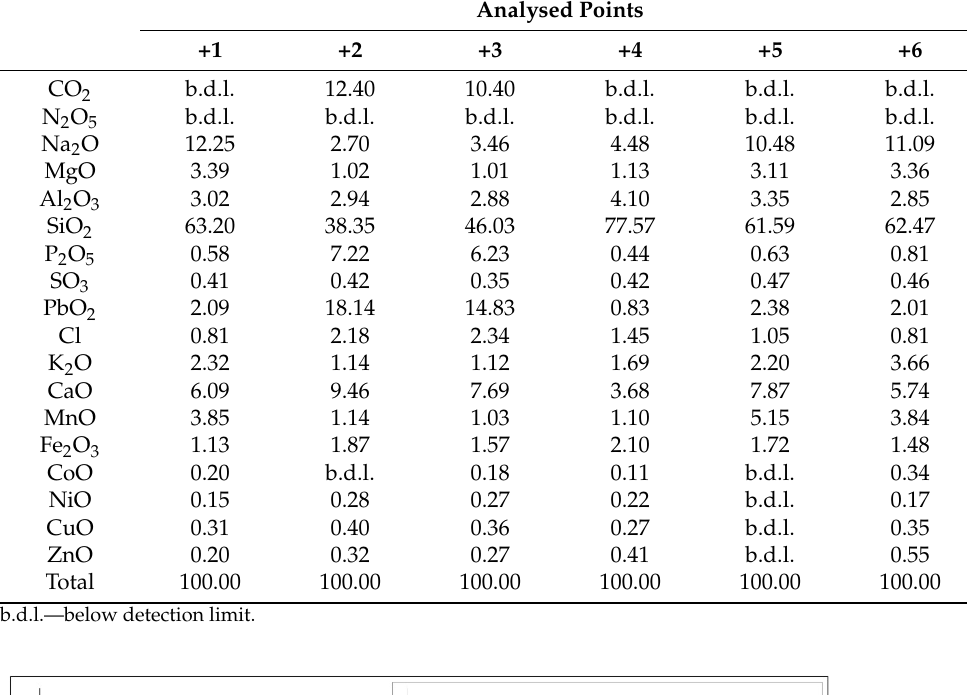
Table 4. Chemical composition, in weight percentage, of the black bead. For all elements (except anion Cl), the composition is expressed as oxides weight %. The exact positions of the analysed points are shown in Figure 10.